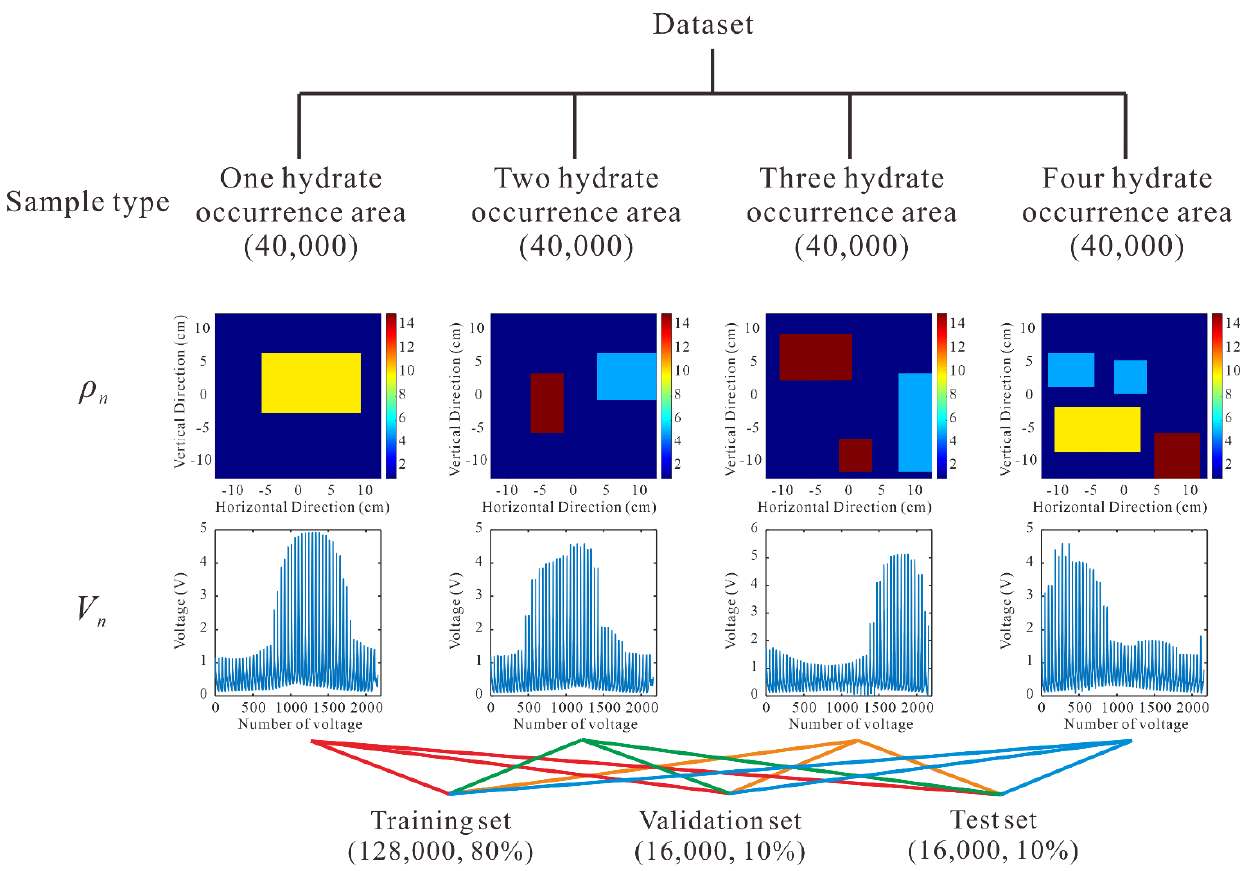
Figure 2. Information about the composition of the data set. The dataset includes four types of hydrate distribution. There are 40,000 samples of each type. Each sample data set includes the resistivity distribution vector and the voltage vector. The dataset is divided into training set, validation, and test set according to the ratio of 8:1:1.